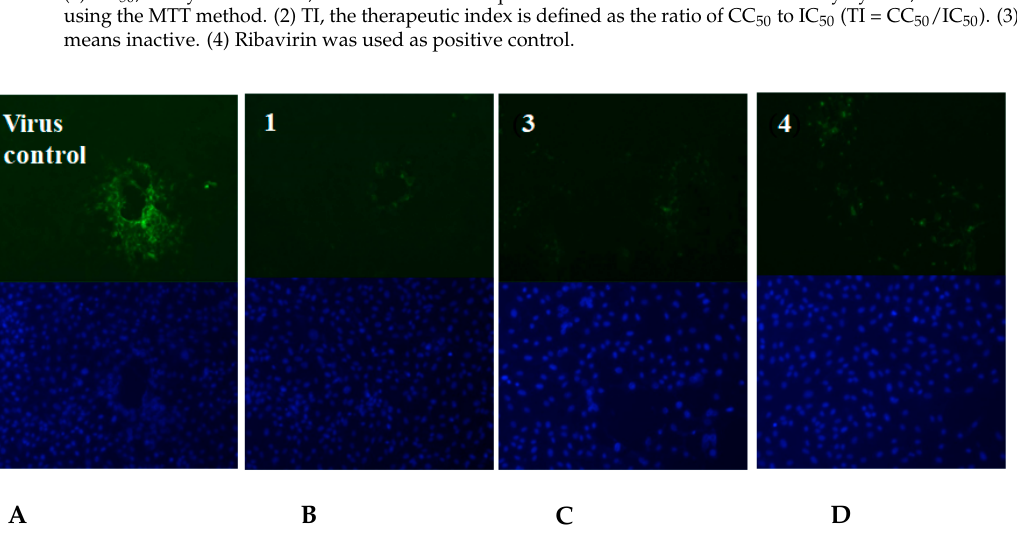
Figure 5. The fluorescent images of the virus control group and the compound-treated cells groups. ( A ) Virus control (PRV); ( B ) compound 1 ; ( C ) compound 3 ; ( D ) compound 4 . (The nucleus was stained with DAPI (blue), and the green foci indicate the presence of PRV protein).